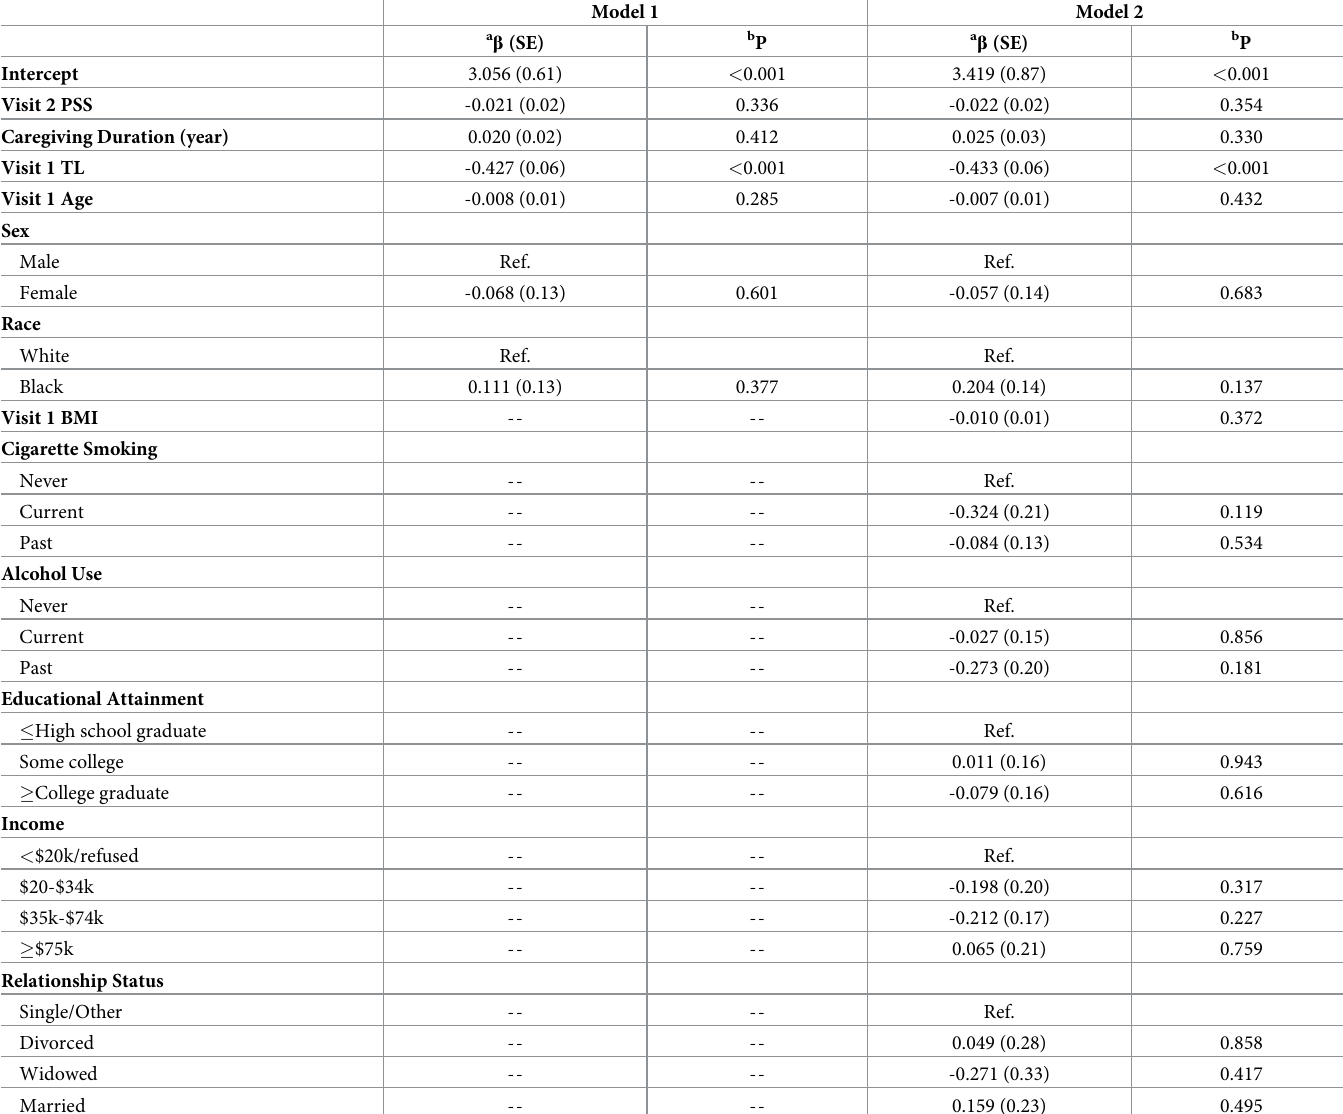
Table 3. Effects of PSS and caregiving duration on Δ T/S in